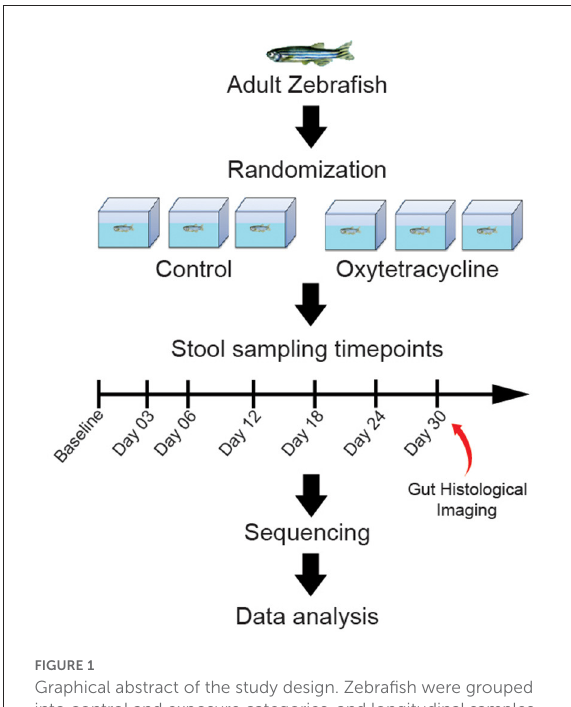
FIGURE1 Graphical abstract of the study design. Zebrafish were grouped into control and exposure categories, and longitudinal samples were collected at Baseline, D03, D06, D12, D18, D24 and D30. The exposure group was exposed to 5000 ng/L of OTC for 30 days whereas no exposue was performed in the control group. The longitudinally collected samples were sequenced and data analysis was